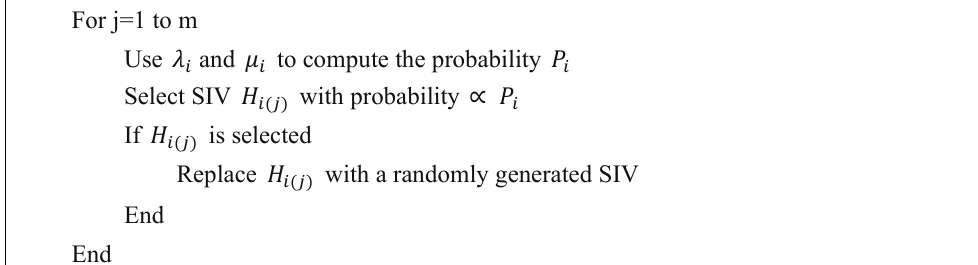
Algorithm 2. Pseudocode of